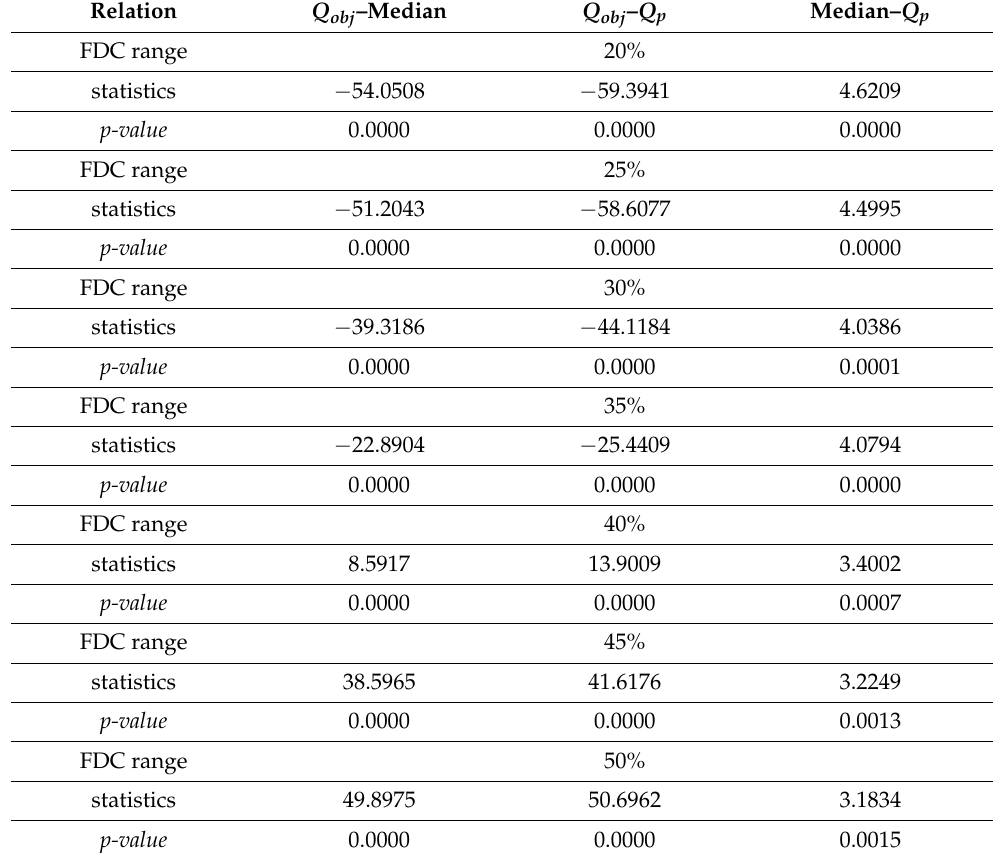
Table 2. Results of T-tests for the comparison of series representing objective thresholds defined using the FJ algorithm ( Q obj ), median value, and middle percentile flow ( Q p ) for multiple FDC ranges. Relation Q obj –Median Q obj – Q